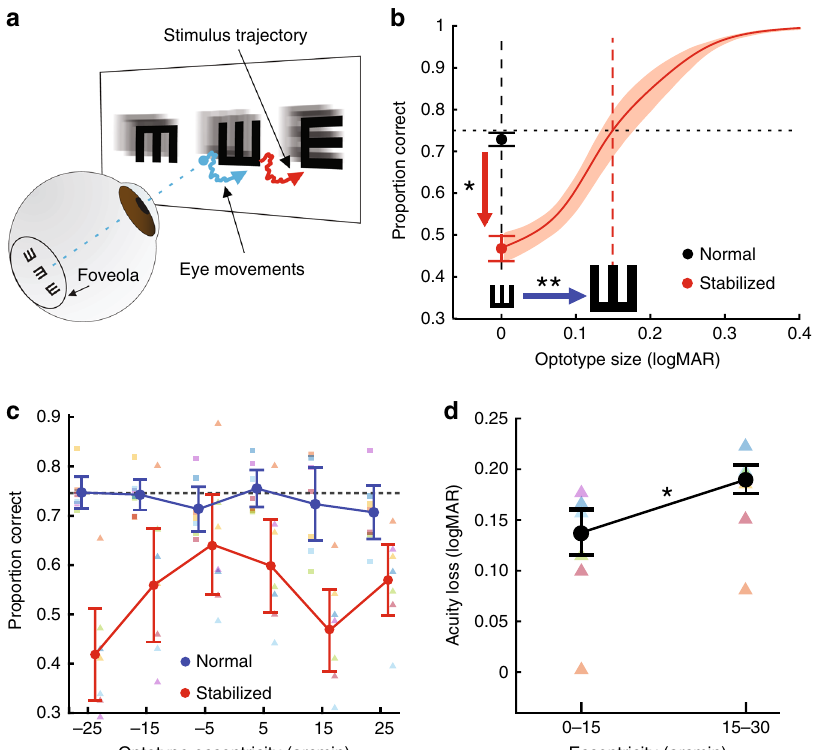
Fig. 4 Oculomotor contributions to acuity. a Retinal stabilization. Stimuli moved on the display under real-time computer control (red arrow) to counteract the motion of the stimulus on the retina caused by eye movements (blue arrow). b Performance as a function of optotype size under retinal stabilization. The red line is the average psychometric function of N = 7 observers. Contrast was individually adjusted to yield ~5% correct identi fi cation during normal unstabilized viewing of 0 logMAR optotypes (black circle). Retinal stabilization greatly impaired performance (red arrow). Increasing the optotype size reestablished threshold level (blue arrow). The shaded region represents SEM (* p = 0.003, two-tailed paired t -test; ** p = 0.002, two-tailed paired t -test). c Performance by optotype position in the 20/20 line. Filled circles represent averages across subjects for optotypes at different eccentricities on the display. Performance under retinal stabilization was signi fi cantly lower at all positions ( p < 0.03; one-tailed paired t -test). Squares and triangles represent individual data under normal and stabilized viewing, respectively. Error bars represent SEM. d Acuity loss in the central 0 – 15 ′ and in the 15 0 – 30 0 range of foveal eccentricity. Black circles and error bar represent medians and SEM across subjects ( * p = 0.0008, two-tailed paired t -test). Triangles are individual subject data. Source data are provided as a source data fi